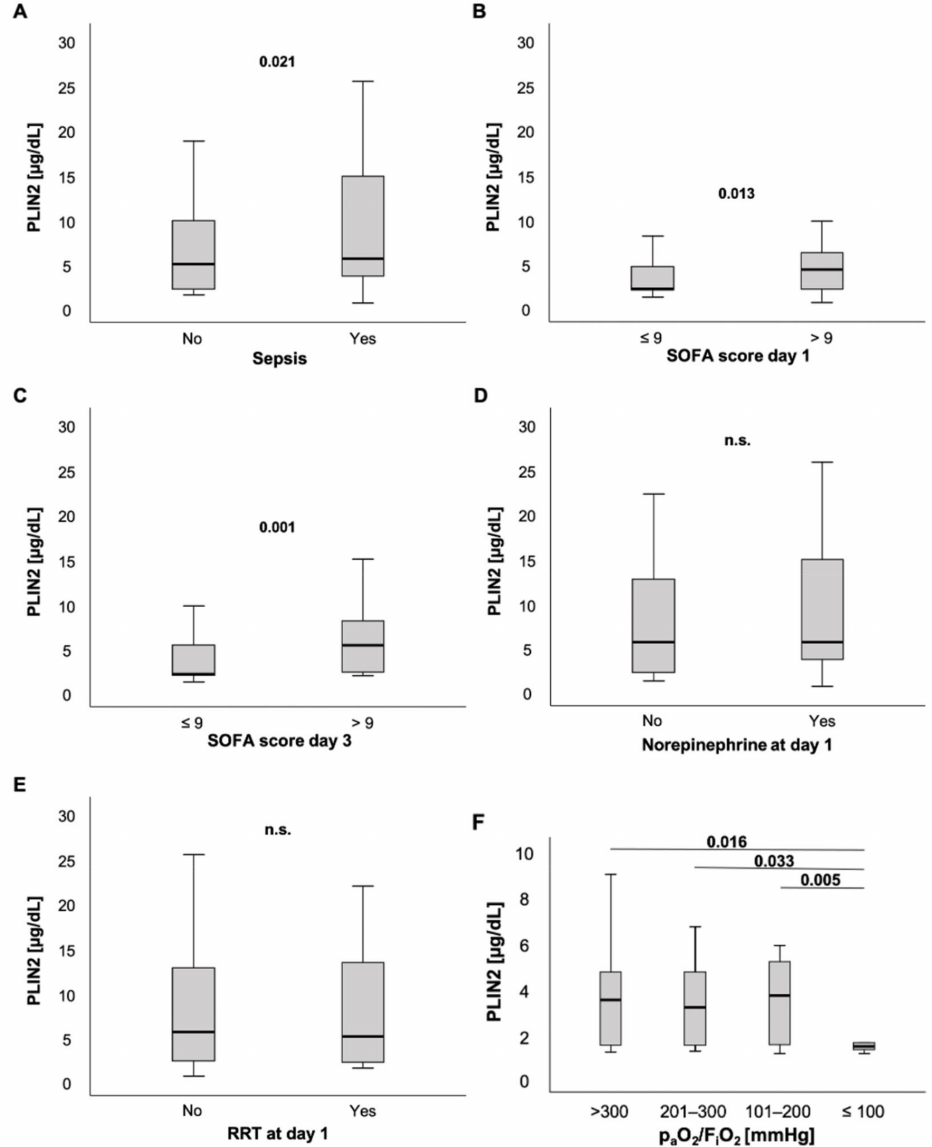
Figure 3. PLIN2 levels in different subsets of ICU patients. ( A ) PLIN2 serum concentrations were elevated in ICU patients with sepsis. ( B ) ICU patients with a SOFA score > 9 points had higher serum PLIN2 levels. ( C ) Serum PLIN2 on the day of ICU admission was higher in ICU patients with a SOFA score > 9 points at ICU day 3. ( D , E ) Neither patients with norepinephrine ( D ) nor renal replacement therapy demand showed differences in PLIN2 levels ( E ). ( F ) Serum PLIN2 levels in the different PaO 2 /FiO 2 (Horovitz index) subgroups are